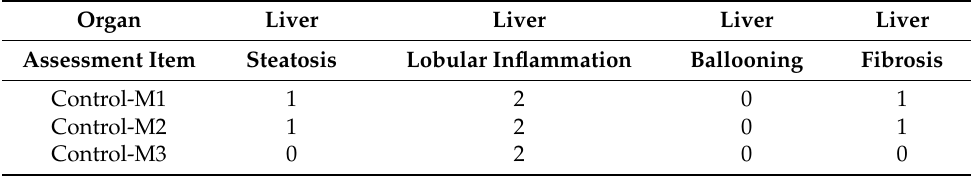
Table 4. Summary of histopathological characteristics of the liver in experiment 2.